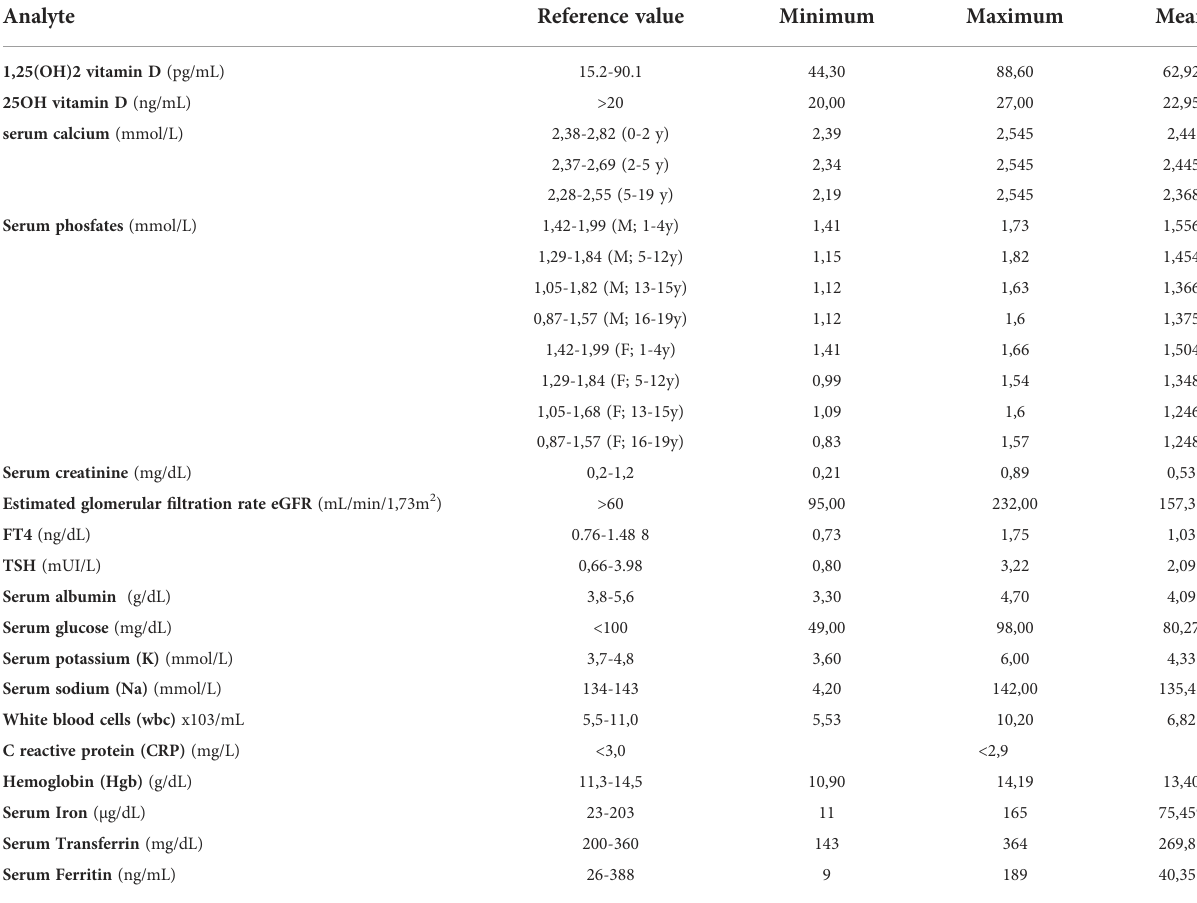
TABLE 1 Descriptive statistics of the distribution of the values of the analytes assayed.